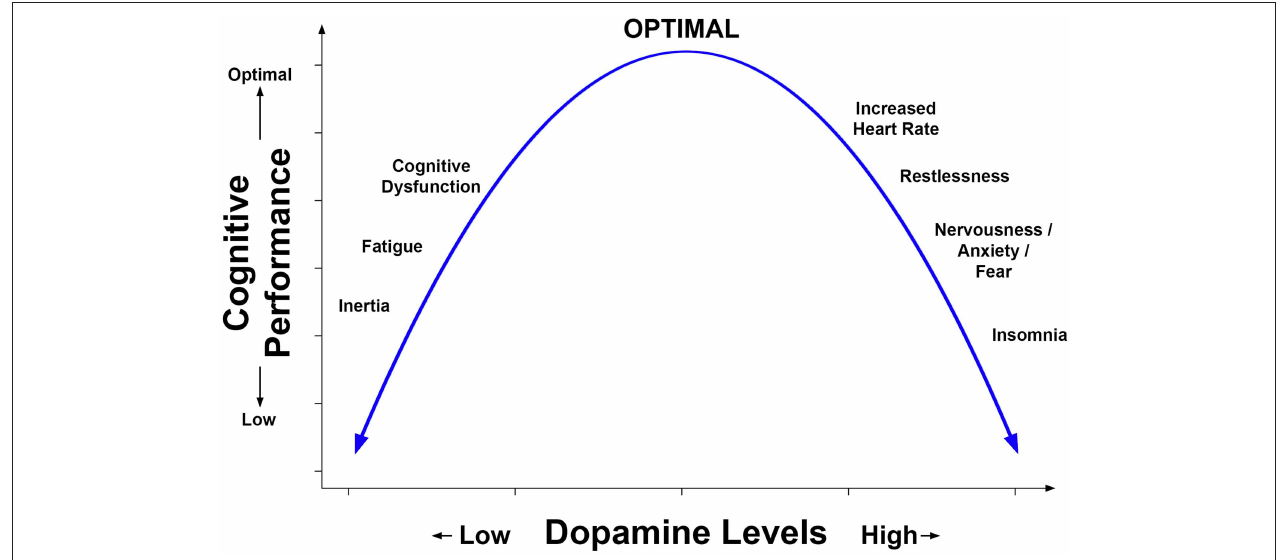
FIGURE 2 | Representation of the inverted U -shaped relation of prefrontal dopamine level to cognitive performance and symptoms. This relation is based in part on animal models including the work by Arnsten et al. (4) and has been described in reports concerning the effects of dopamine agonists on cognition and behavior in